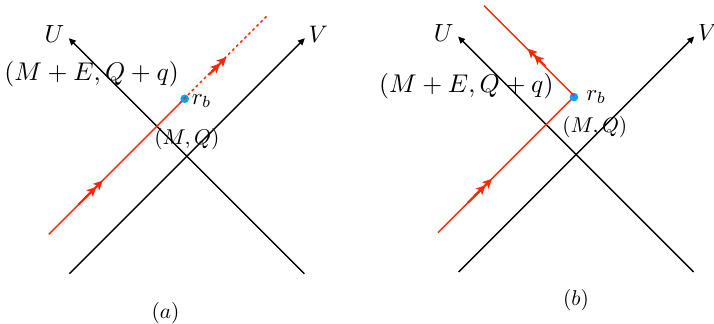
Figure 2 . (a) Null energy condition is violated beyond r b . (b) Correct trajectory of a charged